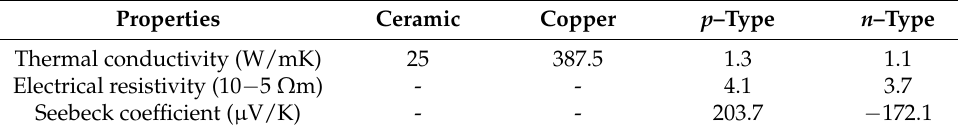
Table 2. Properties of material.